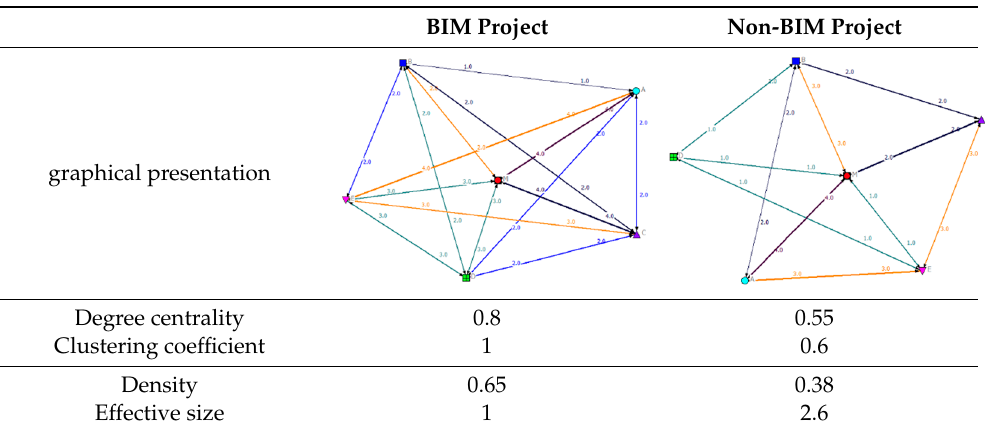
Table 2. The major network indices for the ego network.